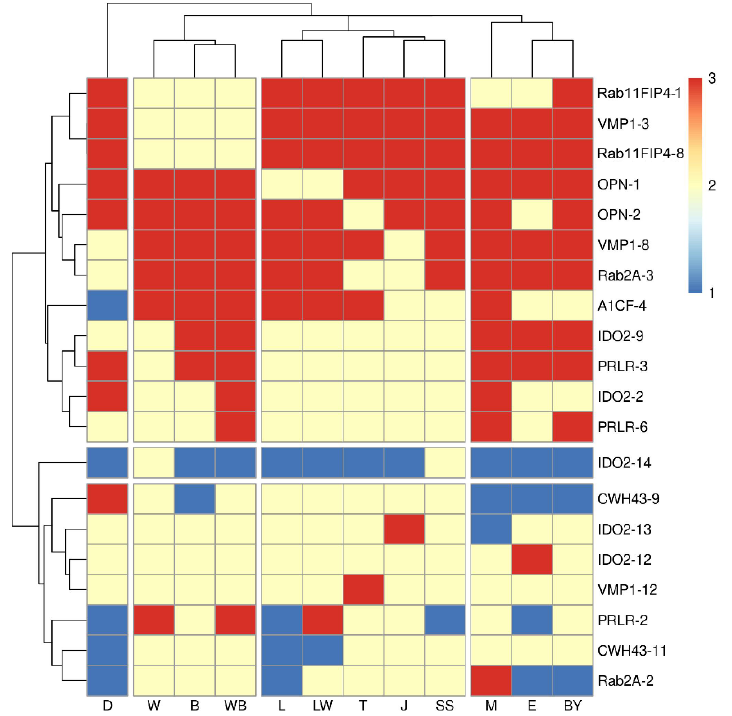
Figure 1. The heatmap results for the pool-PCR of D (Duroc), W (Wuzhishan), B (Bama), WB (Wild-breed), L (Landrace), LW (Large White), T (Tibetan), J (SuJiang), SS (SuShan), M (Meishan), E (Erhualian), and BY (BY). We defined blue block as homozygous insertion, yellow block as heterozygosis insertion, and red block as homozygous deletion in the genome of different pig breeds. After transforming, the pool-PCR electrophoretic results were numerated and the data were processed to make a clustering analysis. The results were clustered into three gene-row parts, and the breeds column into four parts, thus (i) the breeds of Meishan and Erhualian; (ii) Wuzhishan and Bama; (iii) Landrace, Large White, Sujiang, and Sushan together; (iv) the breed of Duroc as standalone. We defined the red blocks as homozygous deletion enriched on the top, the blue blocks as homozygous insertion enriched at the bottom, and the other yellow blocks were heterozygosis insertion. We discovered that nearly 60% of these